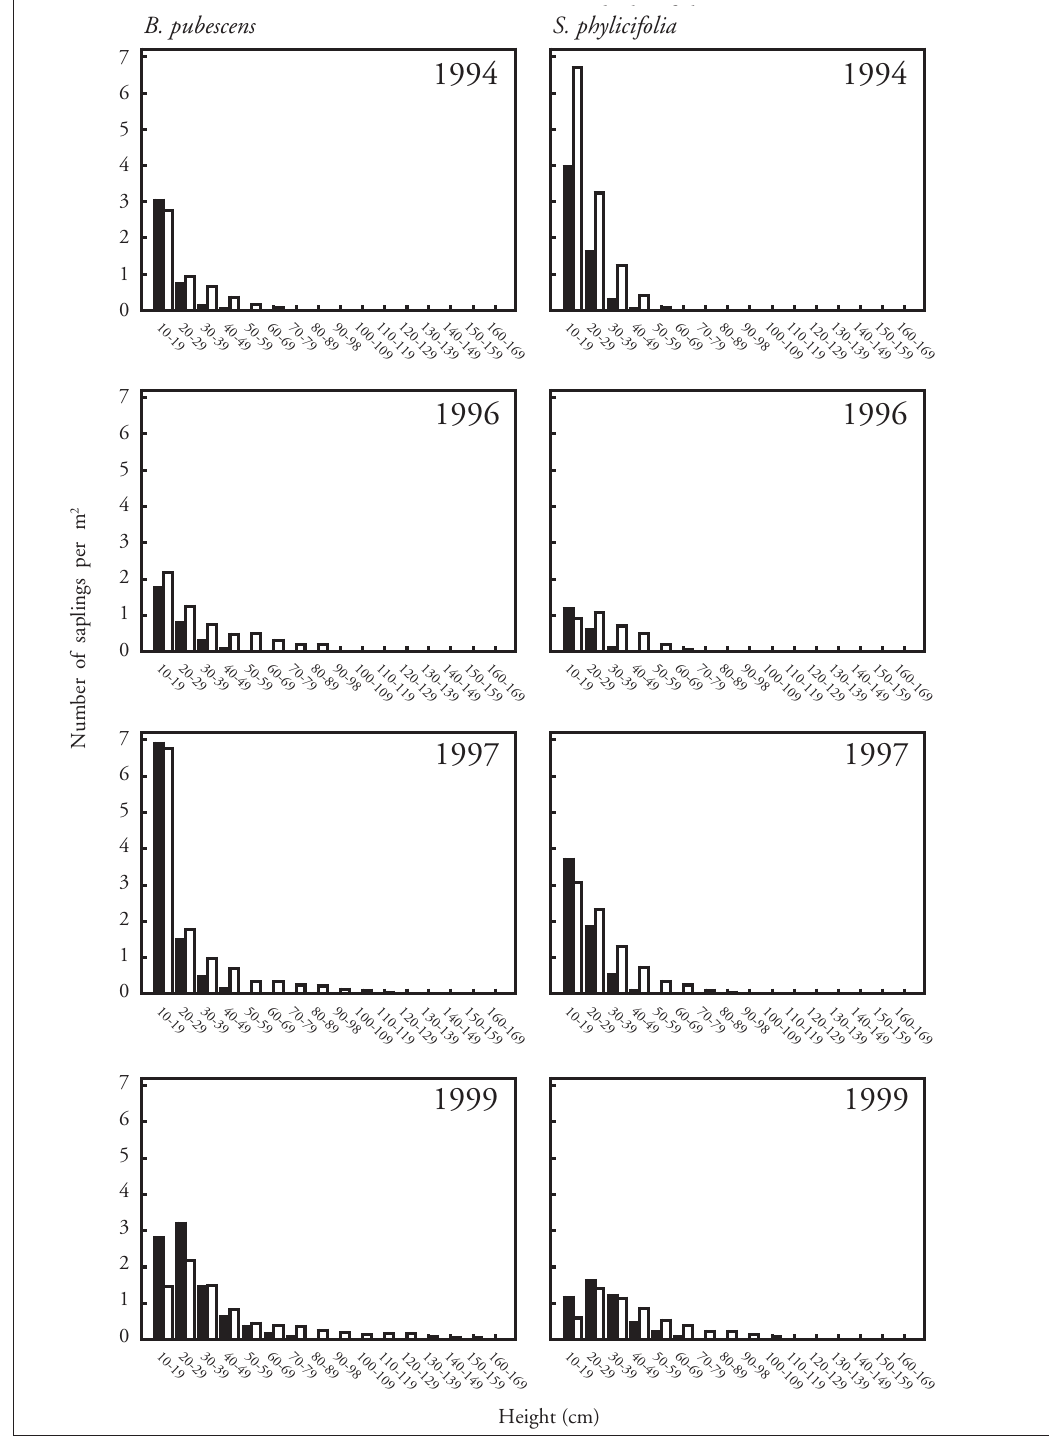
Fig. 5. Height distribution of Betula pubescens subsp. czerepanovii and Salix phylicifolia in the period 1994-1999 in browsed and unbrowsed